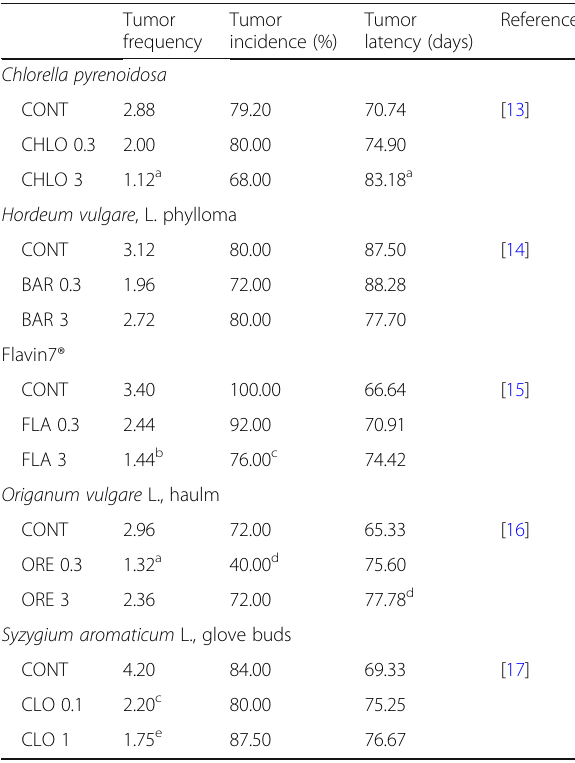
Table 1 Evaluation of anti-tumor effects of plant-derived foods/ nutraceuticals in rat mammary carcinoma model